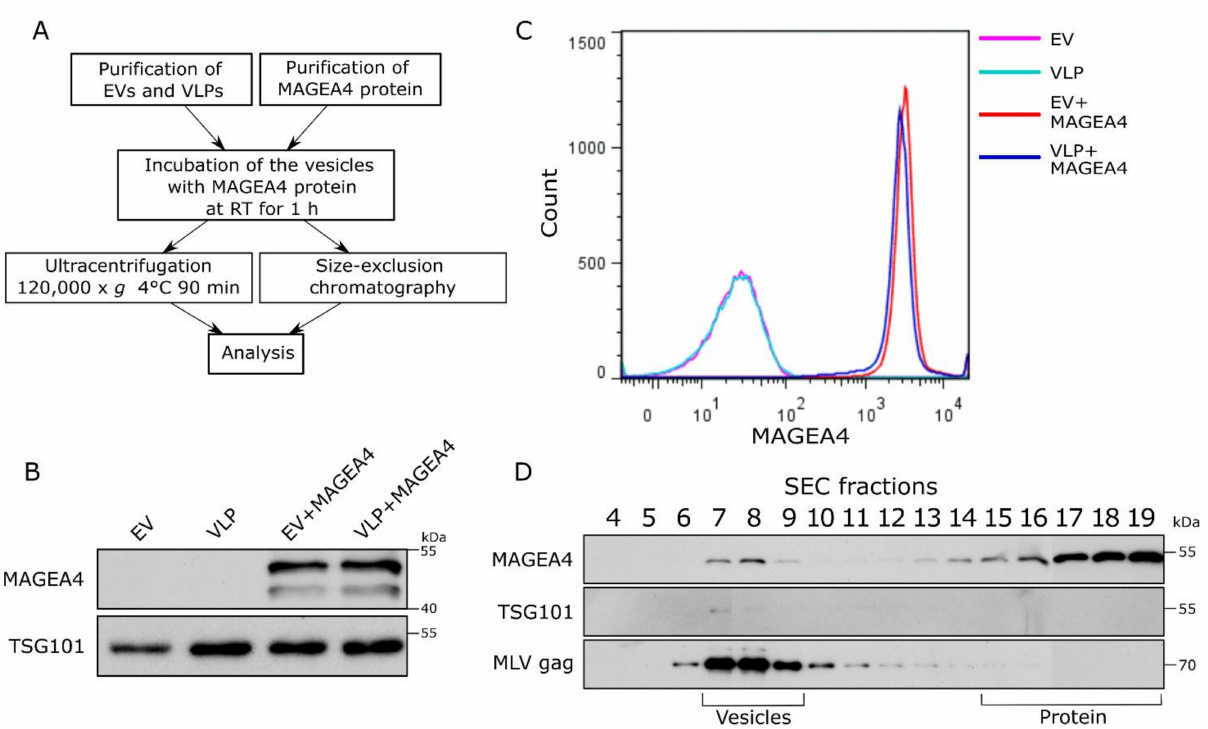
Figure 4. MAGEA4 is able to bind to the surface of vesicles in vitro. ( A ) The scheme of the experiment. Purified EVs and VLPs were incubated with the MAGEA4 protein for 1 h at room temperature following purification through ultracentrifugation or fractionation by SEC. ( B ) Western blot analysis of EVs after incubation with the MAGEA4 protein and purification by ultracentrifugation using antibodies against the MAGEA4 protein. ( C ) Analysis of MAGEA4 binding to the surface of EVs after in vitro binding and purification by ultracentrifugation. Flow cytometry was performed with anti- MAGEA4 and Alexa 488-conjugated secondary antibodies. ( D ) Western blot analysis of SEC fractions after the incubation of MAGEA4 and VLPs in vitro. Antibodies against MAGEA4, TSG101, and MLV Gag were used. The positions of vesicles and proteins according to the manufacturer are